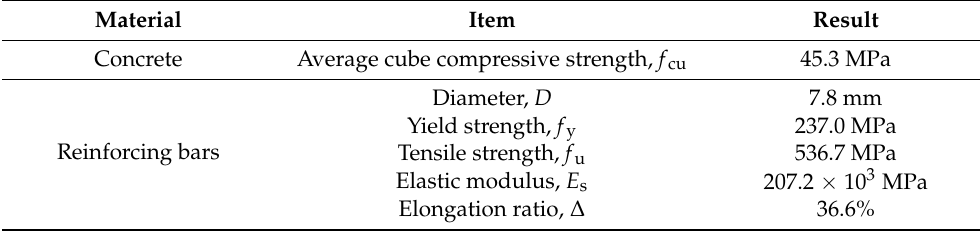
Table 1. Mechanical properties of concrete and reinforcing bars.